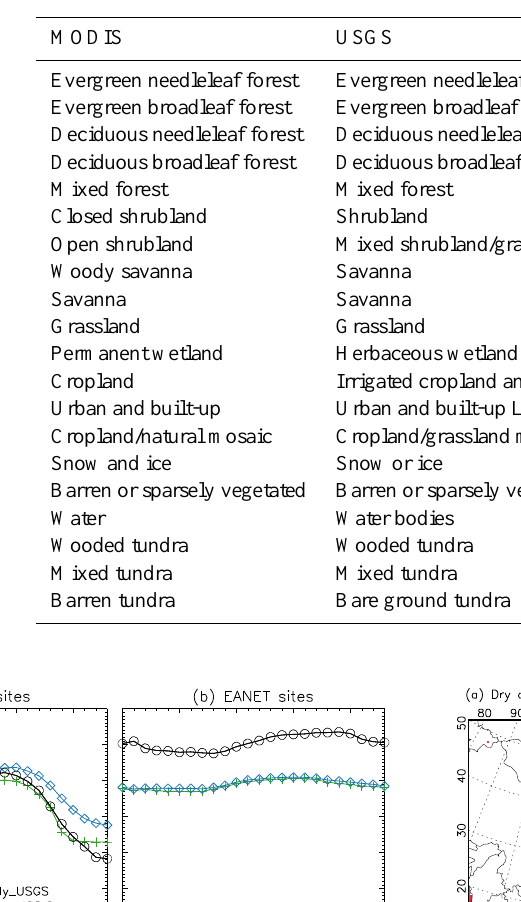
Table 5. Land-use mapping between the 20-category International Geosphere-Biosphere Programme (IGBP)-Modified MODIS and 24- category USGS schemes.